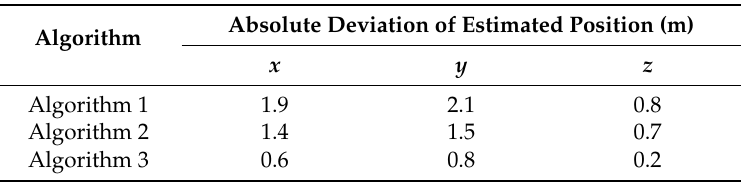
Table 1. Comparison of targeting results from different